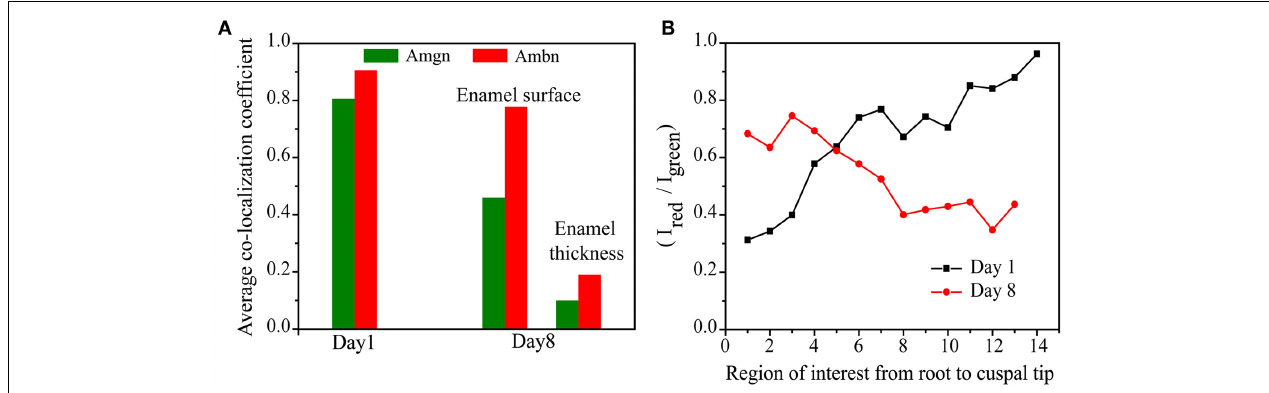
FIGURE 7 | Comparison of (A) the differences in the average co-localization coefficients of Amgn and Ambn at P1 and P8 and (B) intensity ratio of total sum of intensities of red to green channels of each region of interest along the enamel surface.